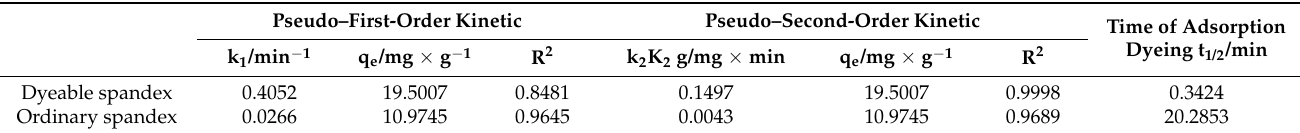
Table 1. Kinetic model parameters of spandex dyeing with neutral red